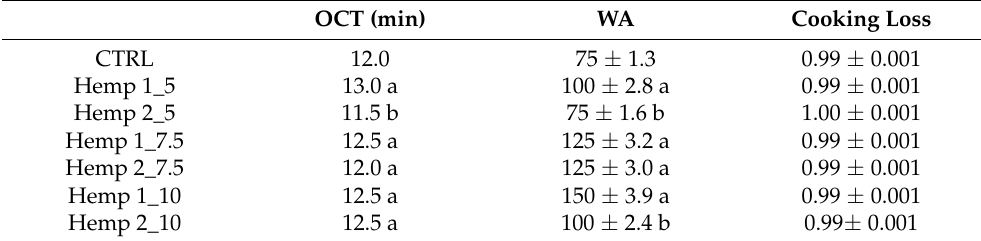
Table 10. The cooking quality, optimum cooking time (OCT), water absorption capacity (WA), and cooking loss of fortified pasta